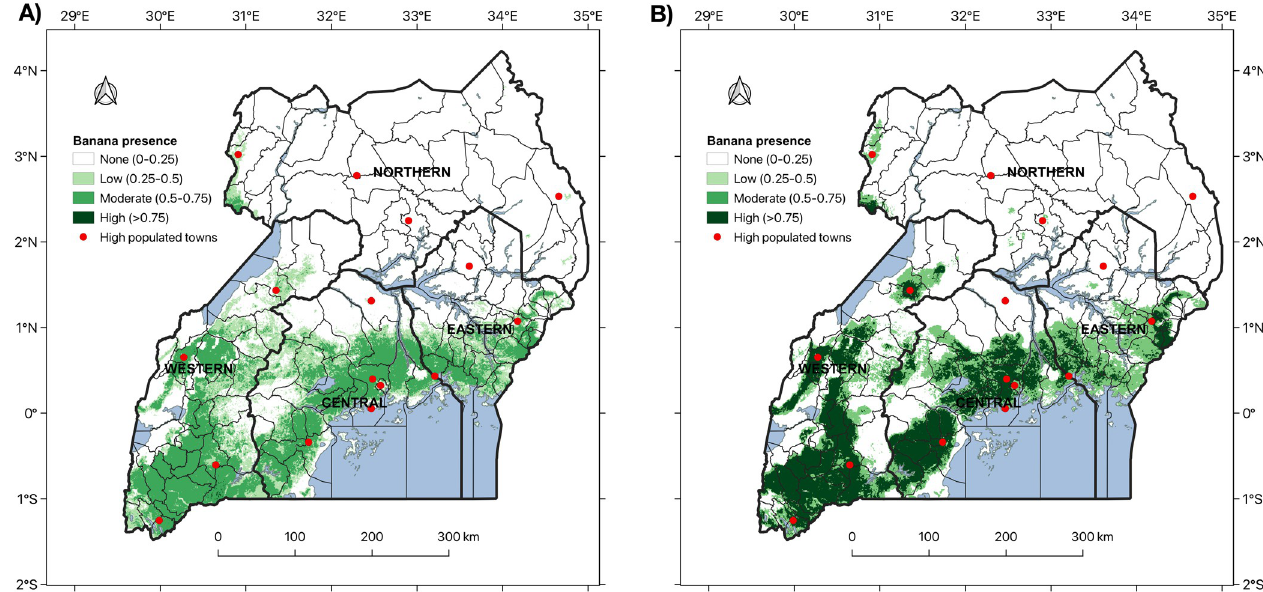
Fig 7. Predicted banana distribution map (2016) using an ensemble model from RF, GBM and NN trained on A) 12 covariates and B) 17 covariates. The maps were refined using the SAGA majority filtering tool within QGIS. Probabilities were converted into categories of banana presence using the probability threshold of 0.25 that maximizes the true positive rate and true negative rate (Max TPR+TNR).